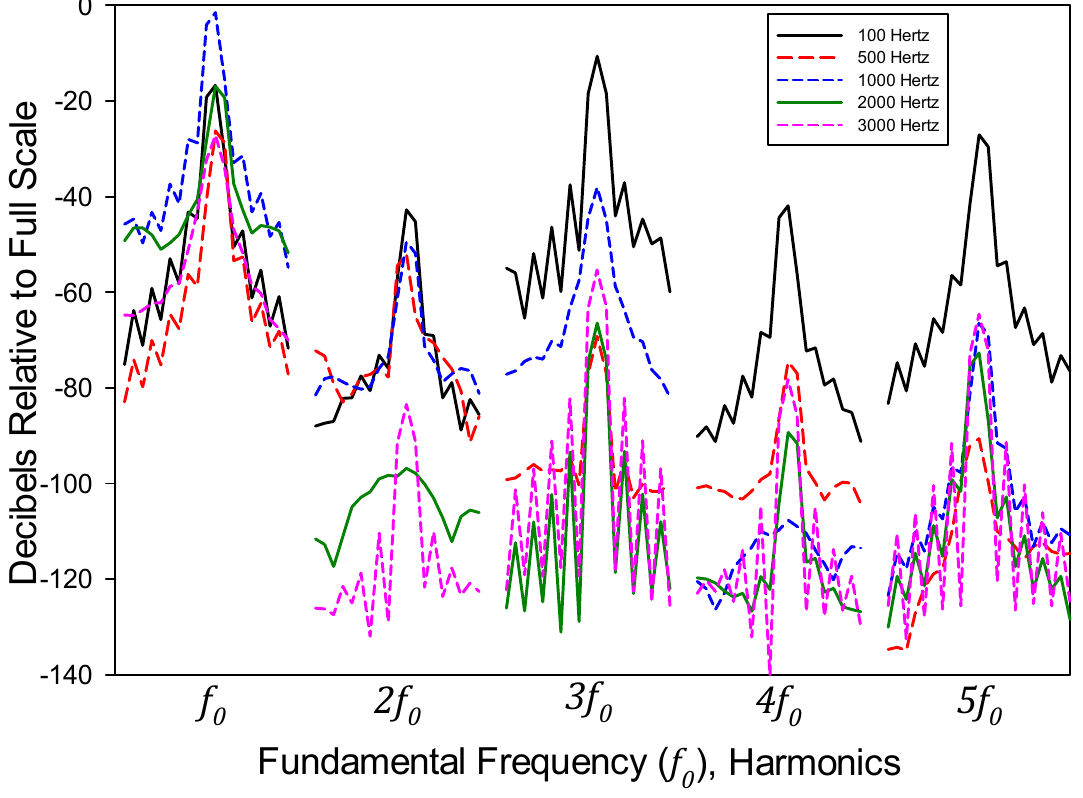
Figure 2. Fundamental excitation frequency ( f 0 ) and first four bubble harmonics of sine waves as played to anaerobic digesters.